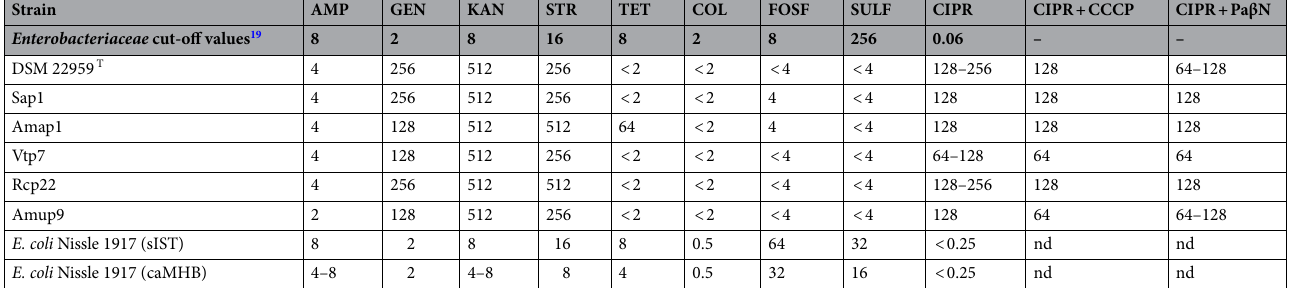
Table 3. MICs (mg l −1 ) of tested antibiotics for A. muciniphila strains. AMP Ampicillin;